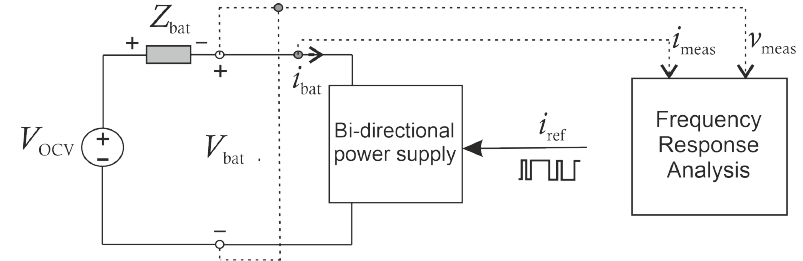
Figure 3. Experimental setup scheme.